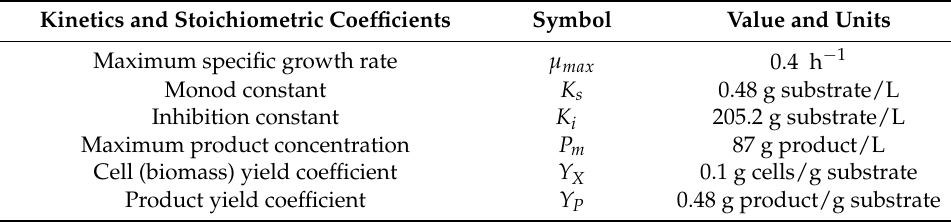
Table 1. Kinetics and stoichiometric coefficients used in the optimization study